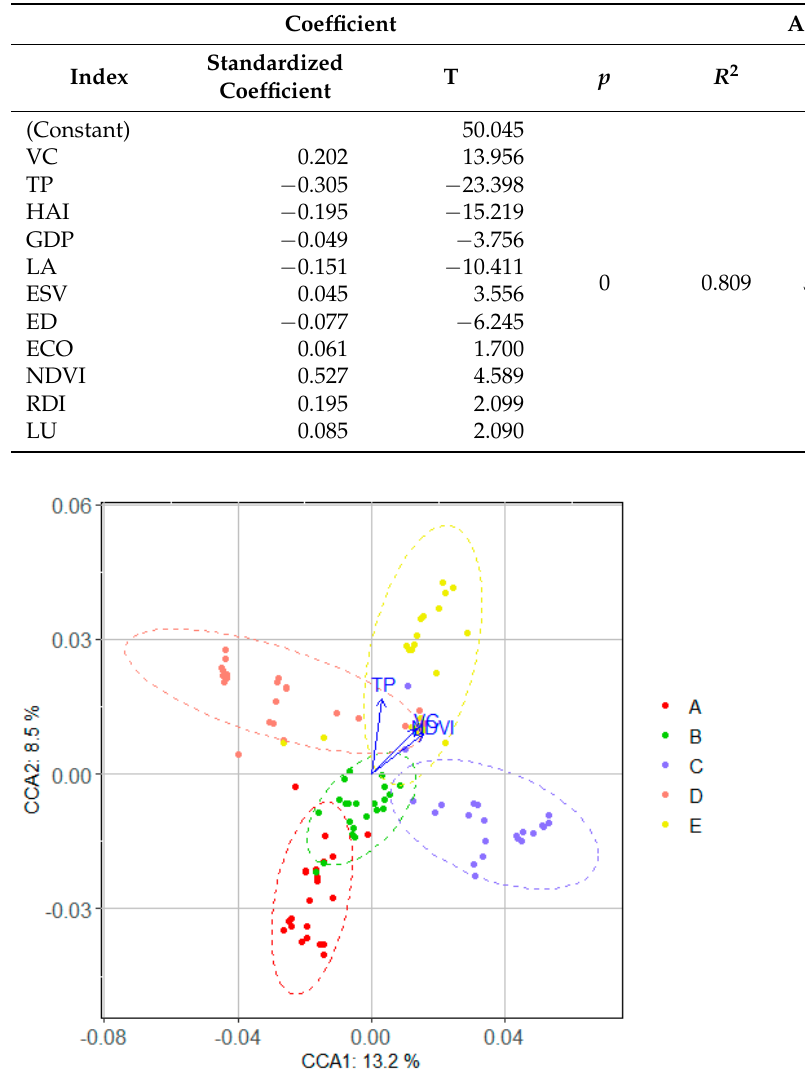
Table 5. Stepwise regression analysis of factors affecting LES. LES represents land ecological security. ANOVA represents the analysis of variance.